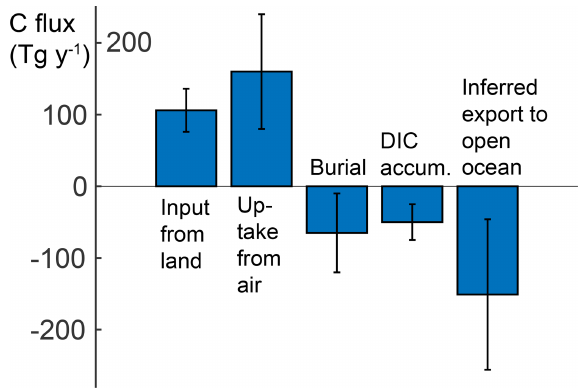
Figure 5. Carbon budget for the EEZ of the USA, Canada, and Mex- ico excluding the EEZs of Hawaii and other islands. Here positive fluxes are a source to the coastal ocean. The accumulation of DIC in EEZ waters is reported with a negative sign to illustrate that all fluxes